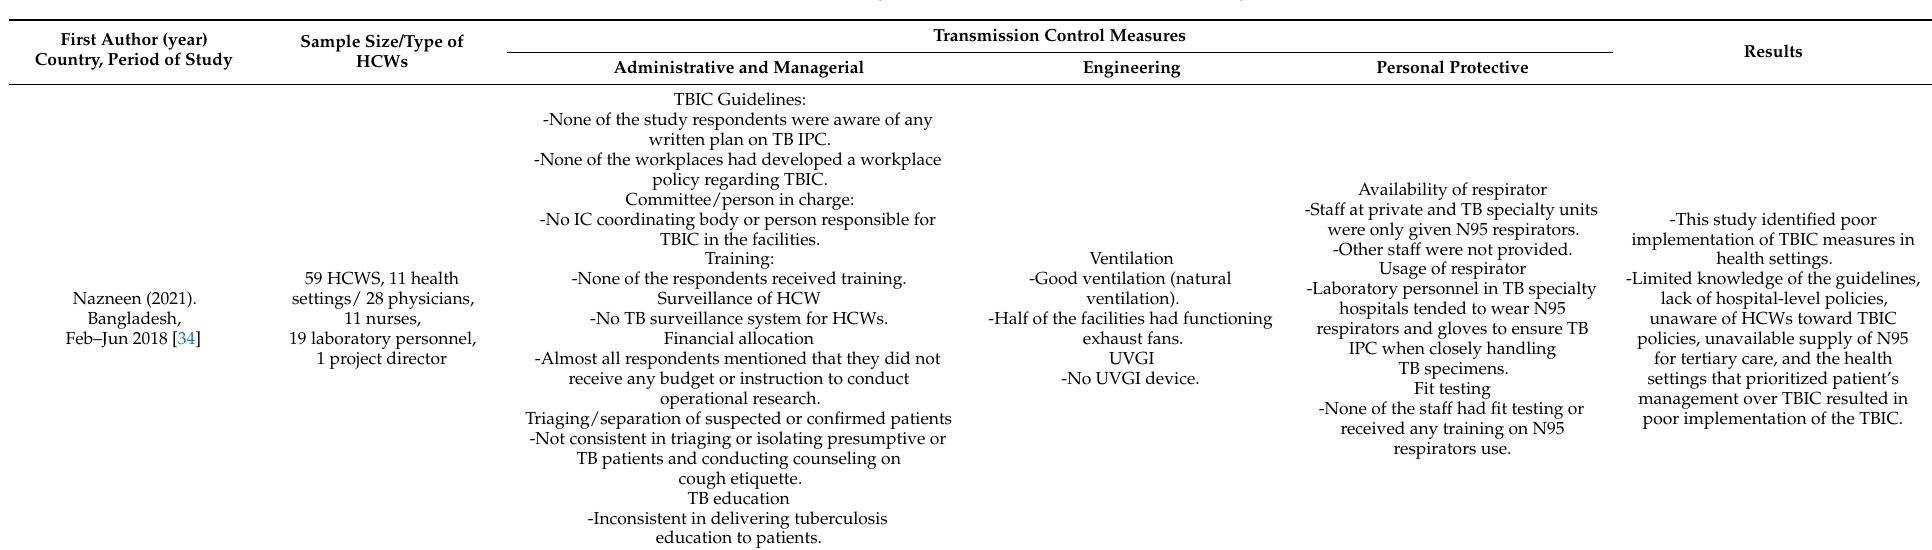
Table 7. A summary of the studies included in this